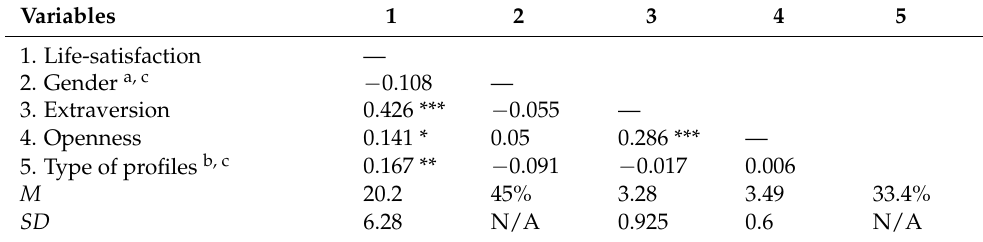
Table 1. Descriptive statistics and Pearson correlations among variables ( N =